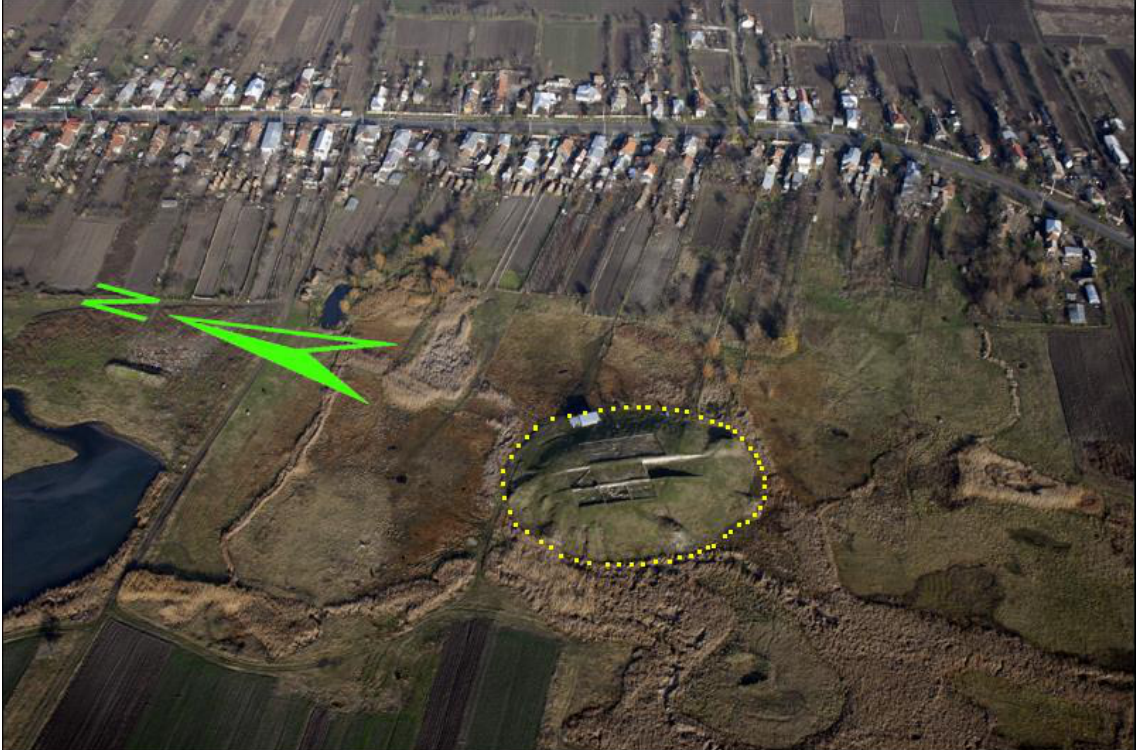
Figure 3. Aerial view of Vităneşti ‘Măgurice’ tell settlement. Photo from Andreescu (2011). (The site, outlined in yellow, is approximately 100 m wide.)